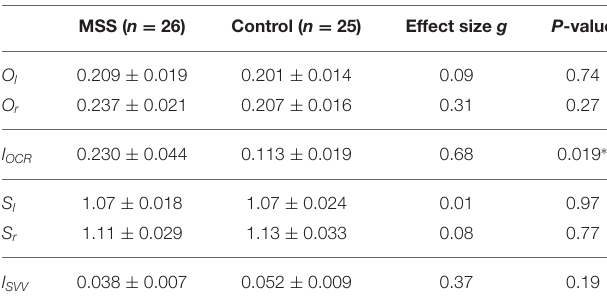
TABLE 1 | Mean and SEM of vestibular function tests in motion sickness susceptible (MSS) and control